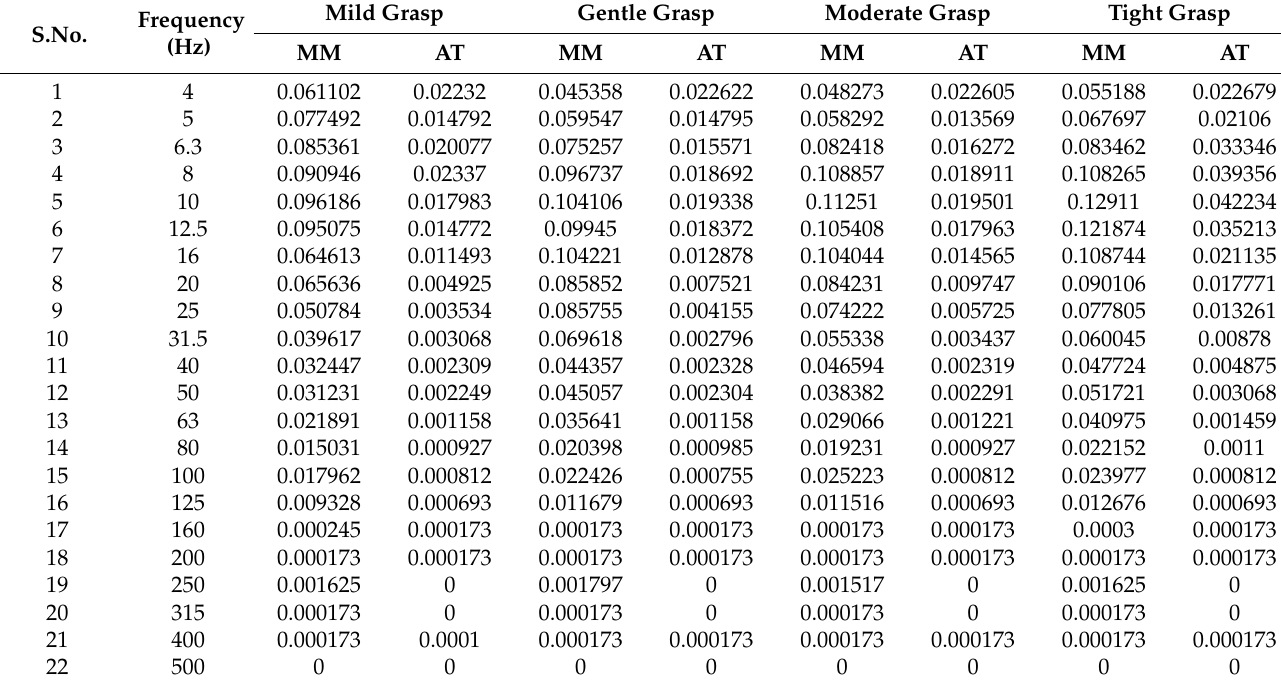
Table 4. 1/3rd-octave band vibration amplitude observations with different grasping conditions.